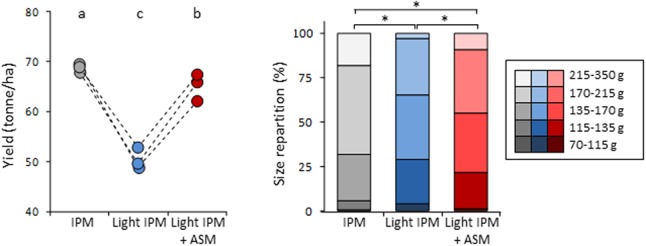
Effect of ASM on fruit yield (Left) and fruit caliber (Right). (Left) Points represent values of yield per hectare and per plot. Values with the same letters are not significantly different (P < 0.05, Kruskall–Wallis test, n = 3). (Right) Star on two stacked bars indicates distributions significantly different (P = 0.05, χ2 test). ASM, acibenzolar-S-methyl; IPM, integrated pest management.